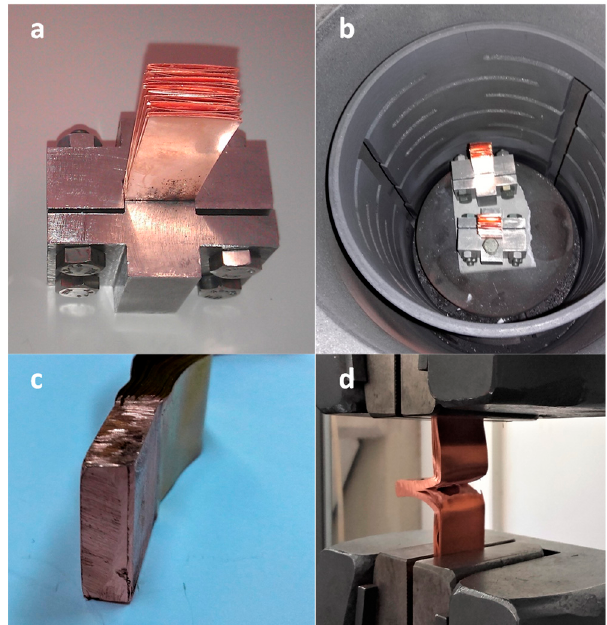
Figure 2. Processing steps of autogenous Cu bonding and mechanical characterization; ( a ) Cu foils in the pressing clamp, ( b ) placement of samples in the graphite furnace, ( c ) Cu foils after bonding and